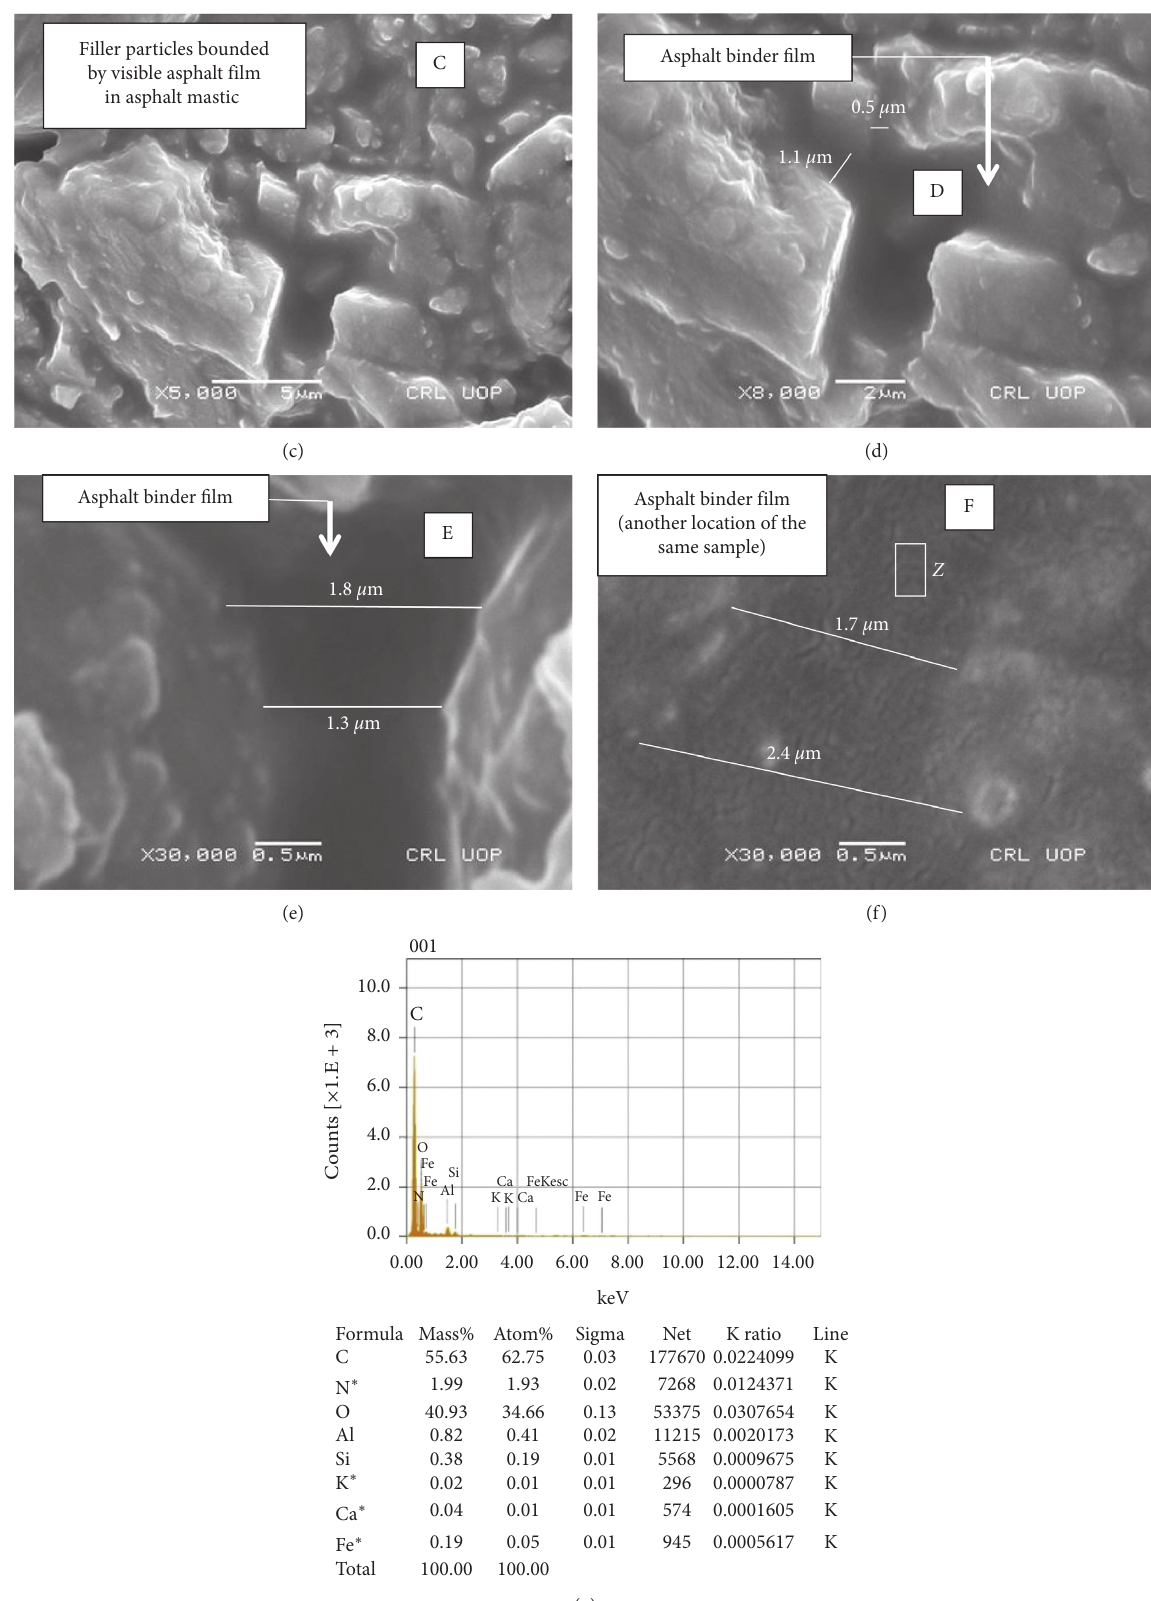
Figure 10: SEM images of HMA at 160 ° C and optimized binder content of 4.12%: (a) asphalt mortar at magnification × 200 and bar scale 100 μ m. (b) Voids in asphalt mastic at magnification × 2500 and bar scale 10 μ m. (c) Filler particles in mastic at magnification × 5000 and bar scale 5 μ m. (d) Asphalt binder film at magnification × 8000 and bar scale 2 μ m. (e) Asphalt binder film at magnification × 30,000 and bar scale 0.5 μ m. (f) Asphalt binder film at another location of the same sample at magnification × 30,000 and bar scale 0.5 μ m. (g) Elemental composition of asphalt binder film at point Z in image (f) by